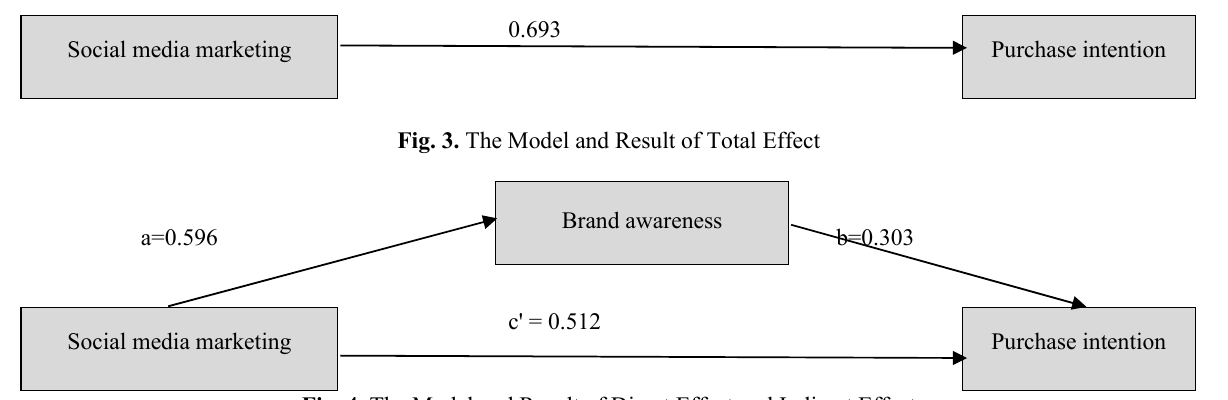
Fig. 3. The Model and Result of Total Effect